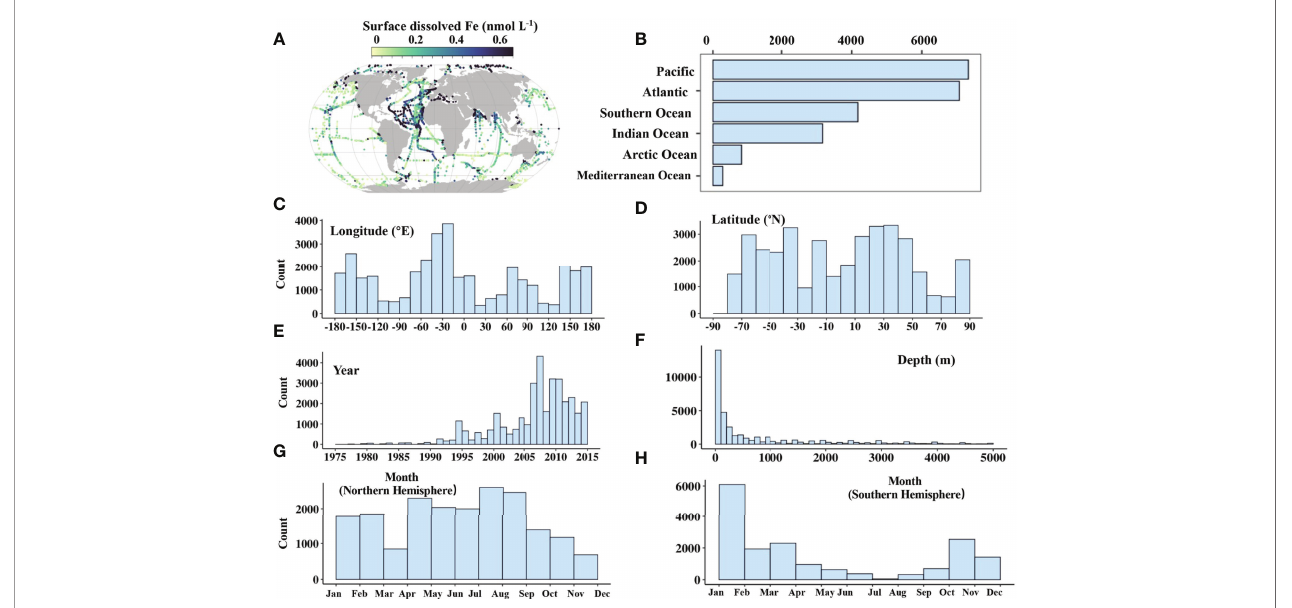
FIGURE 1 | DistributionofcompiledglobalobservationdatasetofdissolvedFewiththerespecttosurfaceocean (A) , mainoceanbasin (B) , longitude (C) , latitude (D) , sampling year (E) , samplingdepth (F) andmonth (G,H) . TheSouthernOceanisde fi nedas theregionsouthof40°S.Thedelineationofeachoceanbasinisshownin FigureS3 .